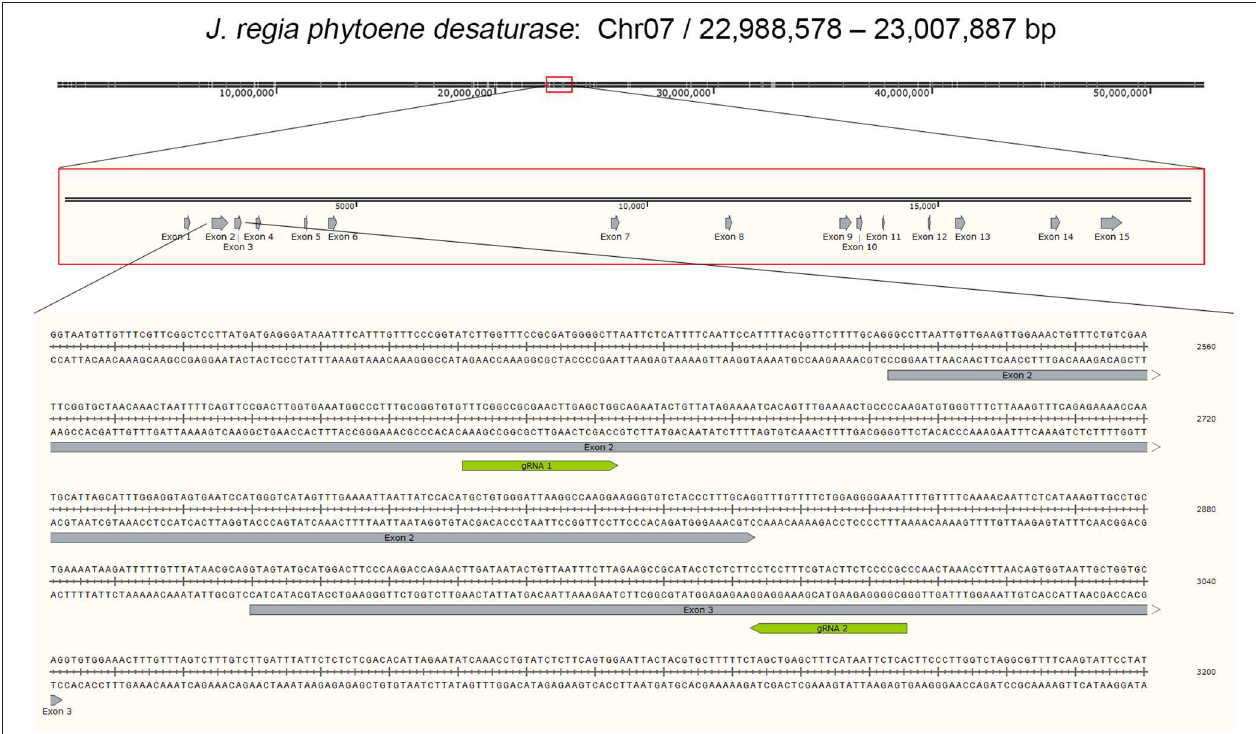
FIGURE 2 | Gene model of JrPDS . Representation of chromosome 7 from Juglans regia cv. Chandler, highlighting the genome vicinity containing CDS Jr07_15220 encoding Phytoene desaturase. The zoomed region shows the relative size and location of the 15 exons. The bottom panel shows in further detail the segment comprising exons 2 and 3, and the location of 2 selected